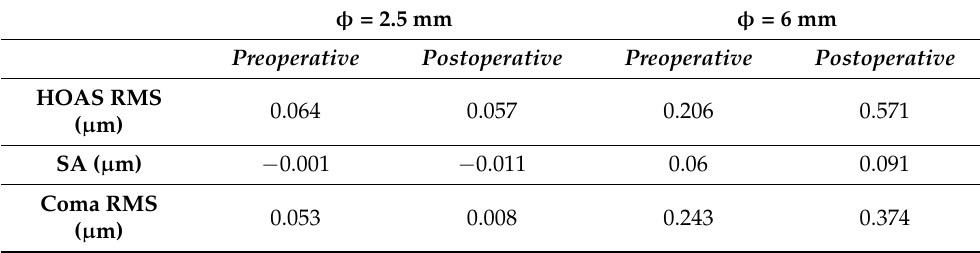
Table 5. Preoperative and postoperative RMS HOAS, SA and RMS coma values of Eye 2 for 2.5 mm and 6 mm pupil sizes.